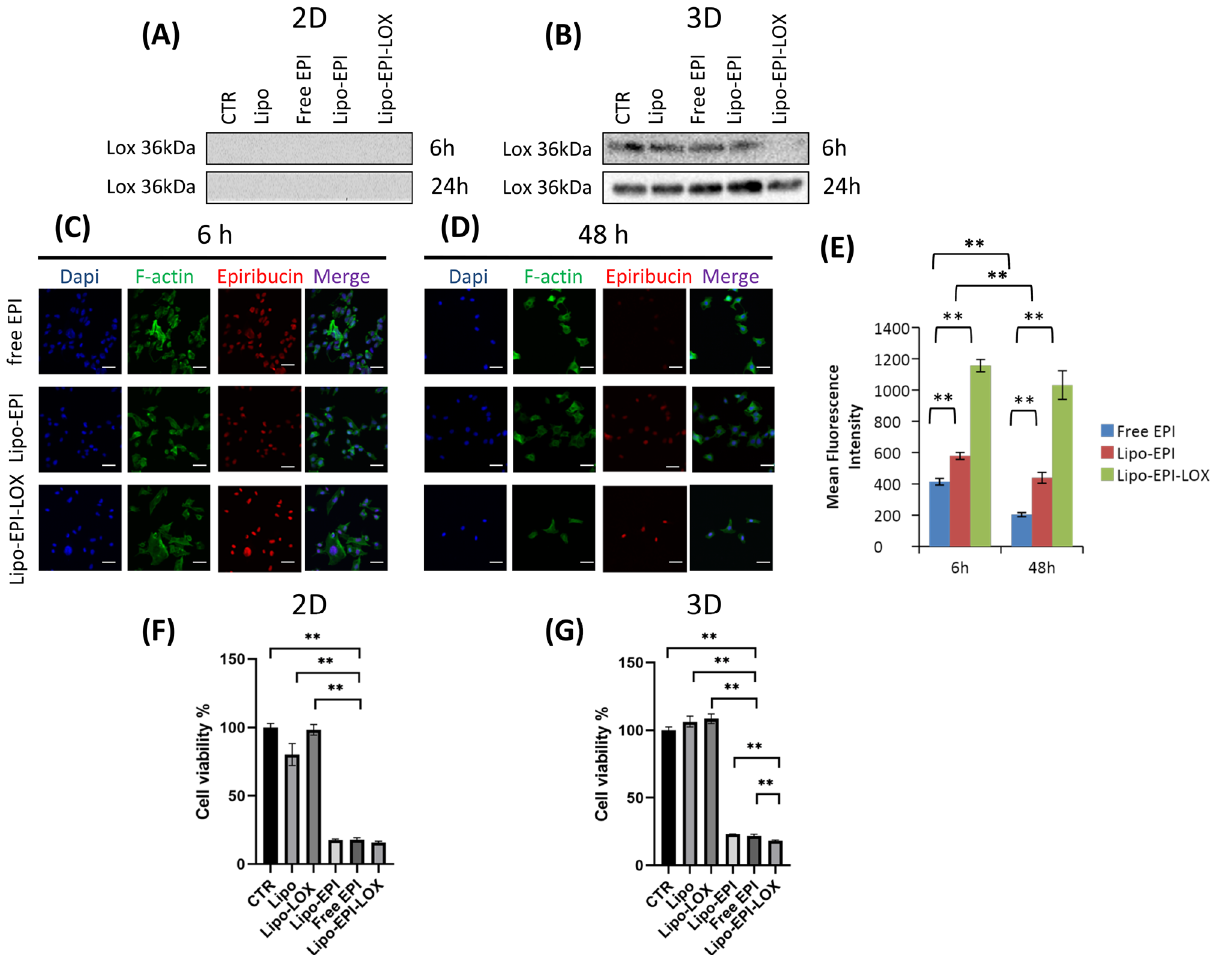
Figure 2. ( A ) Protein analysis of secreted LOX in monolayer cultures not treated and treated with all formulations, full-length blots/gels are presented in Supplementary Fig. 2A. ( B ) Protein analysis of secreted LOX in 3D cultures not treated and treated with all formulations, full-length blots/gels are presented in Supplementary Fig. 2B, C. ( C ) Confocal analysis of 3D cultures exposed to formulations encapsulated with anthracycline after 6 h from the exposure. Nuclei were stained with dapi (blue), actin filaments were stained with phalloidin (green), epirubicin (red) and merge. ( D ) Confocal analysis of 3D cultures exposed to formulations encapsulated with anthracycline after 48 h from the exposure. Scale bar 50 µm ( E ) Mean fluorescence intensity of anthracycline detected after 6 and 48 h. ( F ) Cell viability of tumor cells after treatment with all studied formulations in standard monolayer cultures, negative control is CTR and positive control is LIPO-EPI-LOX. ( G ) Cell viability of tumor cells after treatment with all studied formulations in 3D cultures, negative control is CTR and positive control is LIPO-EPI-LOX. * p < 0.05, ** p <